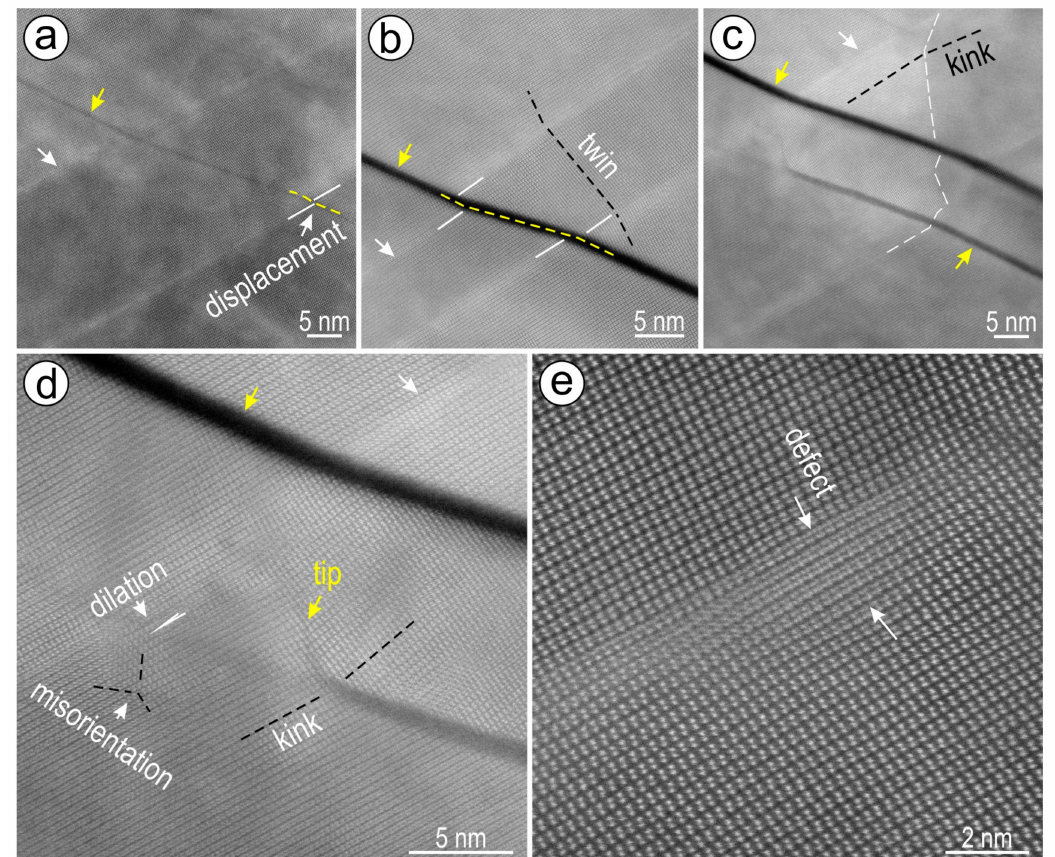
Figure 16. Atomic-scale resolution images showing lattice scale defects associated with crosscutting relationships between Si-Al-K-planes (yellow arrowheads) and twins (white arrowheads) in the weave-twinned hematite (foil #4). ( a , b ) Twin displacements (white bars) with increasing magnitude relative to increasing width of the planes. Note kink bends along the Si-Al-K-planes (dashed yellow lines). Single column atomic arrangement across the twin is marked by black dashed line following (210) direction. ( c , d ) More complex defects in areas with duplex Si-Al-K-planes crosscutting a twin. ( c ) Kink deformation (white dashed line) along the direction of the twin (dashed black line). ( d ) Detail around the tip of Si-Al-K-plane in ( c ) showing nanodomain misorientation, lattice dilation and kink bends as marked. ( e ) Linear defect at the twin plane crest propagating into a planar defect